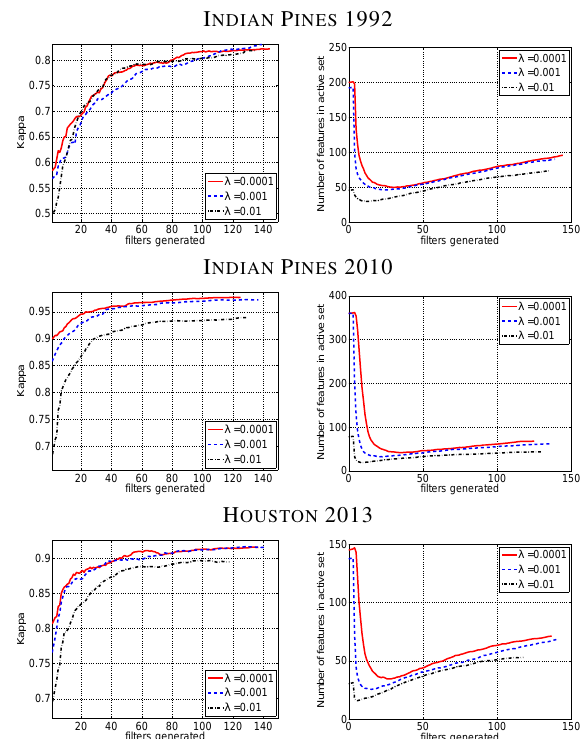
Figure 5: Left: numerical performance (Kappa statistic) for dif- ferent degrees of regularization λ and filtering the original bands. Right: number of active features during the iterations.